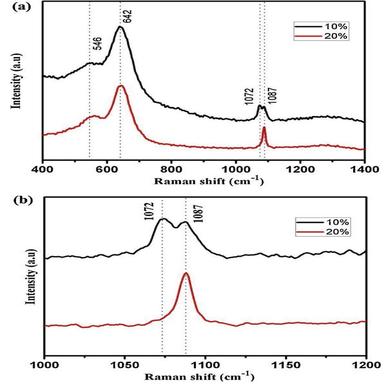
(a) Raman spectra of LSCF/Na2CO3 with different weight ratios. (b) gives an enlarged scale in the range of 1000-1200 cm−1.